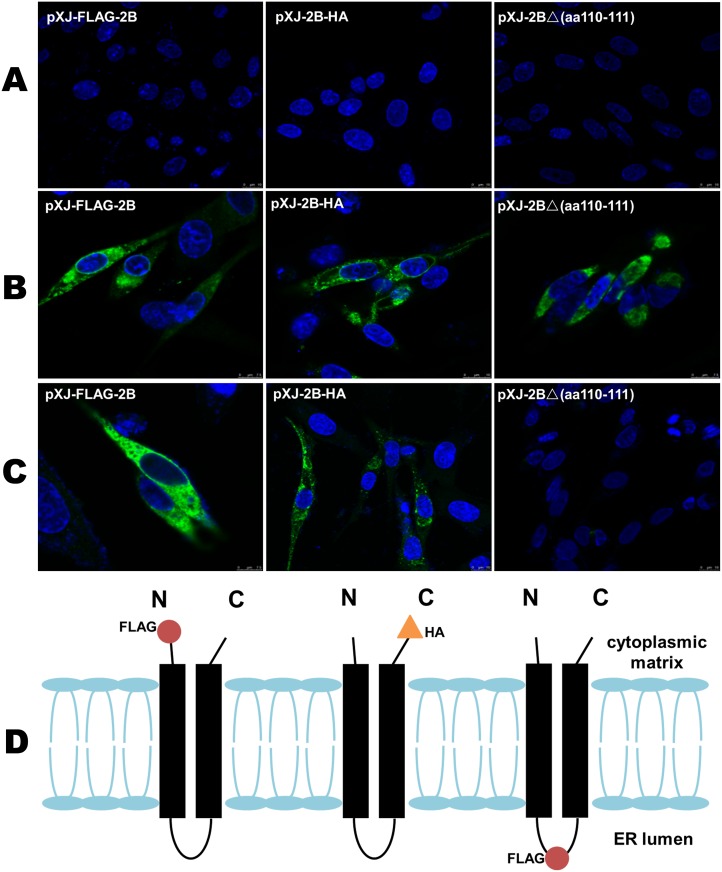
The topological structure of the FMDV 2B protein.Three groups of cells were transfected with pXJ-FLAG-2B, pXJ-2B-HA, or pXJ-2BΔ(110–111). (A) Cells cultured without any treatment. (B) Cells treated with Triton X-100. (C) Cells treated with digitonin. (D) A schematic representation of the predicted topology of the FMDV 2B protein in the ER membrane. The blue fluorescence represents the nucleus, and the green fluorescence represents the FLAG-2B protein or the 2B-HA protein.